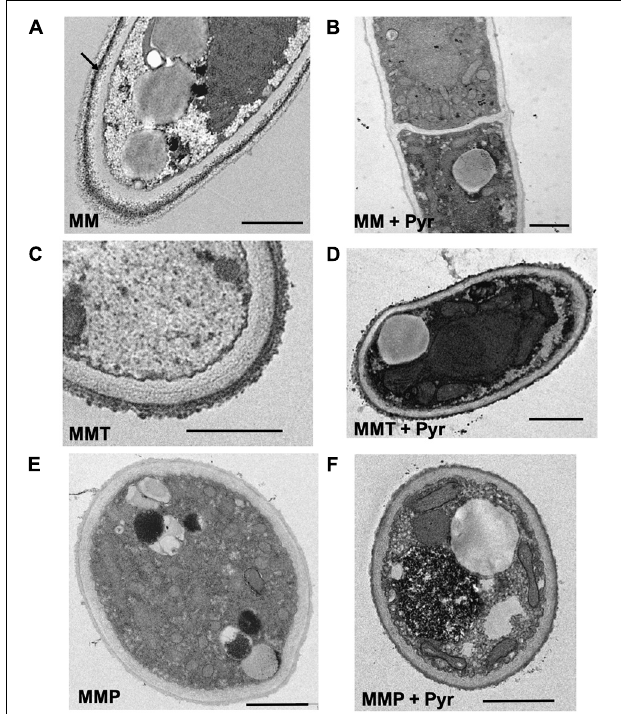
FIGURE 4 | Transmission electron microscopic observations of the hyphae and hyphal cell wall morphology of A. alternata grown under different conditions: (A) MM, (B) MM with the presence of 50 µ g/mL of pyroquilon, (C) MMT, (D) MMT supplemented with 50 µ g/mL of pyroquilon, (E) MMP and (F) MMP + 50 µ g/mL of pyroquilon, after 3 days of growth. Arrow in (A) show an internal melanin layer. Bars, 1,000 nm.